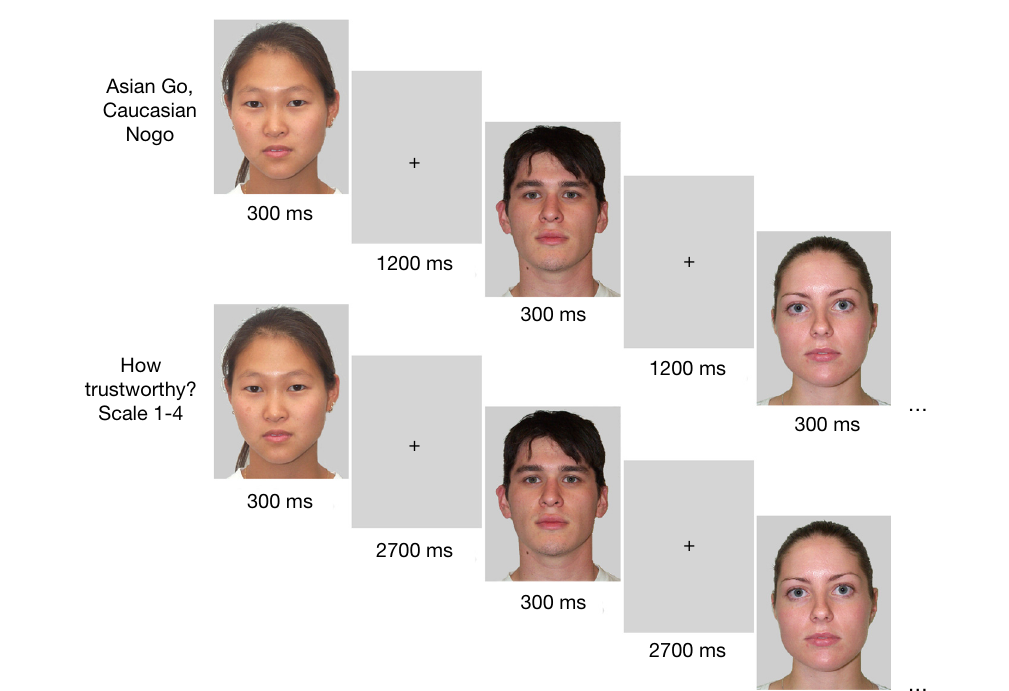
Figure 1 | Example of trial sequence for the Go–Nogo task (top panel) and the evaluation task (bottom